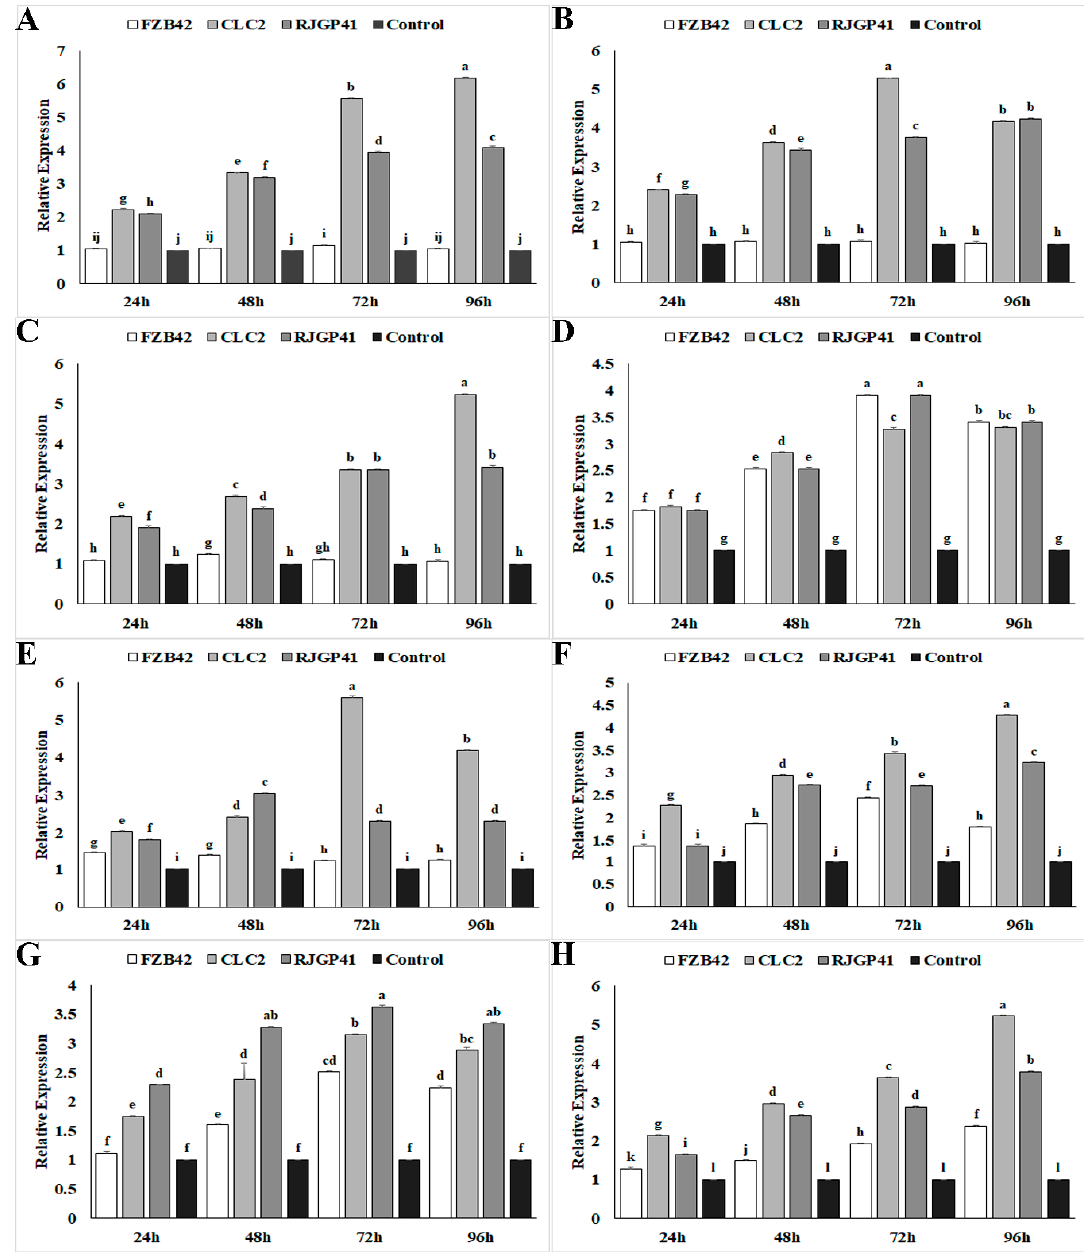
Figure 3. The graphs representing relative expression levels of different genes analyzed at multiple time intervals in Bacillus strains FZB42, CJCL2, and RJGP41 grown at 4 °C and 37 °C. The analyzed genes were: cspB ( A ), cspC ( B ), cspD ( C ), comA ( D ), desK ( E ), desR ( F ), ohrR ( G ), OpuAC ( H ). The error bars on the graphs indicate the standard deviation of the mean ( n = 3). Letters above the columns represent significant differences between treatments at p ≤ 0.05. The expression studies were repeated three times with similar changes in expression.